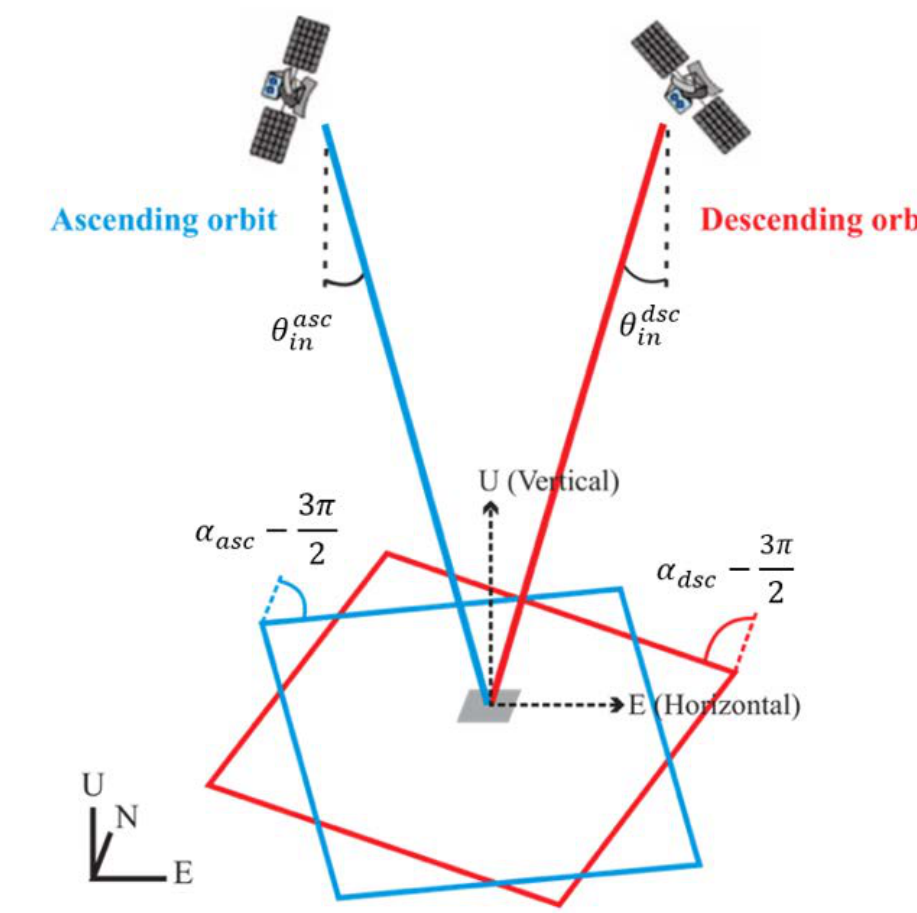
Figure 6. Acquisition geometry of the ascending and descending SAR tracks. The viewing geometry of the satellite LOS is mainly defined by the incidence angle ( θ in ) and satellite heading ( α ). Based on such a geometric simplification, the vertical and horizontal components can be solved.